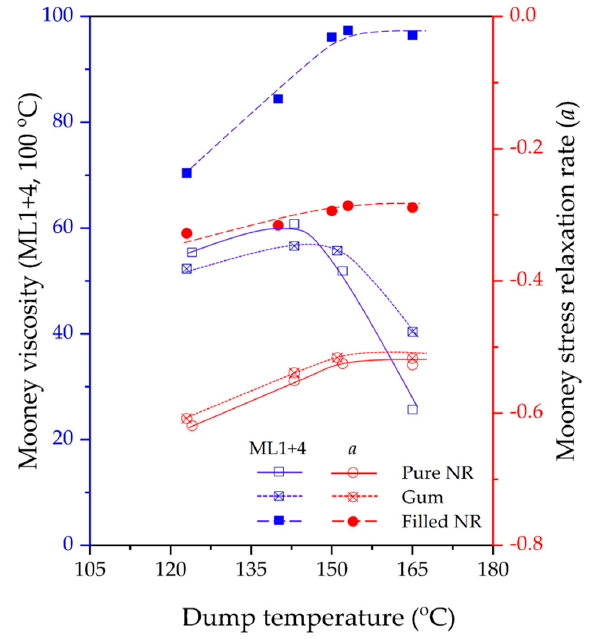
Figure 2. Mooney stress relaxation rate ( a ) and Mooney viscosity, ML1+4 (100 ◦ C) of the masticated pure NR, gum/unfilled, and filled NR compounds subjected to various dump temperatures. Note the negative representation of the Mooney stress relaxation rate ( a ).